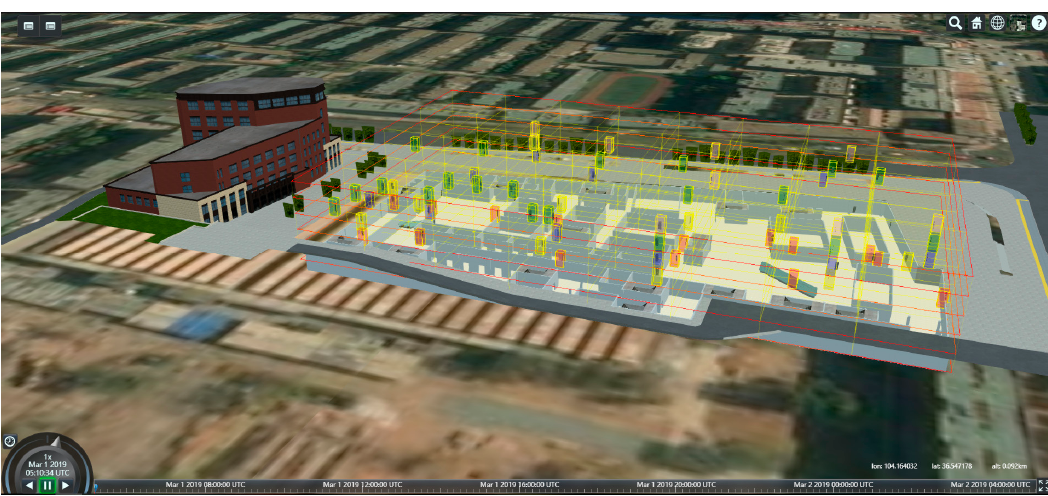
Figure 15. Model partition.